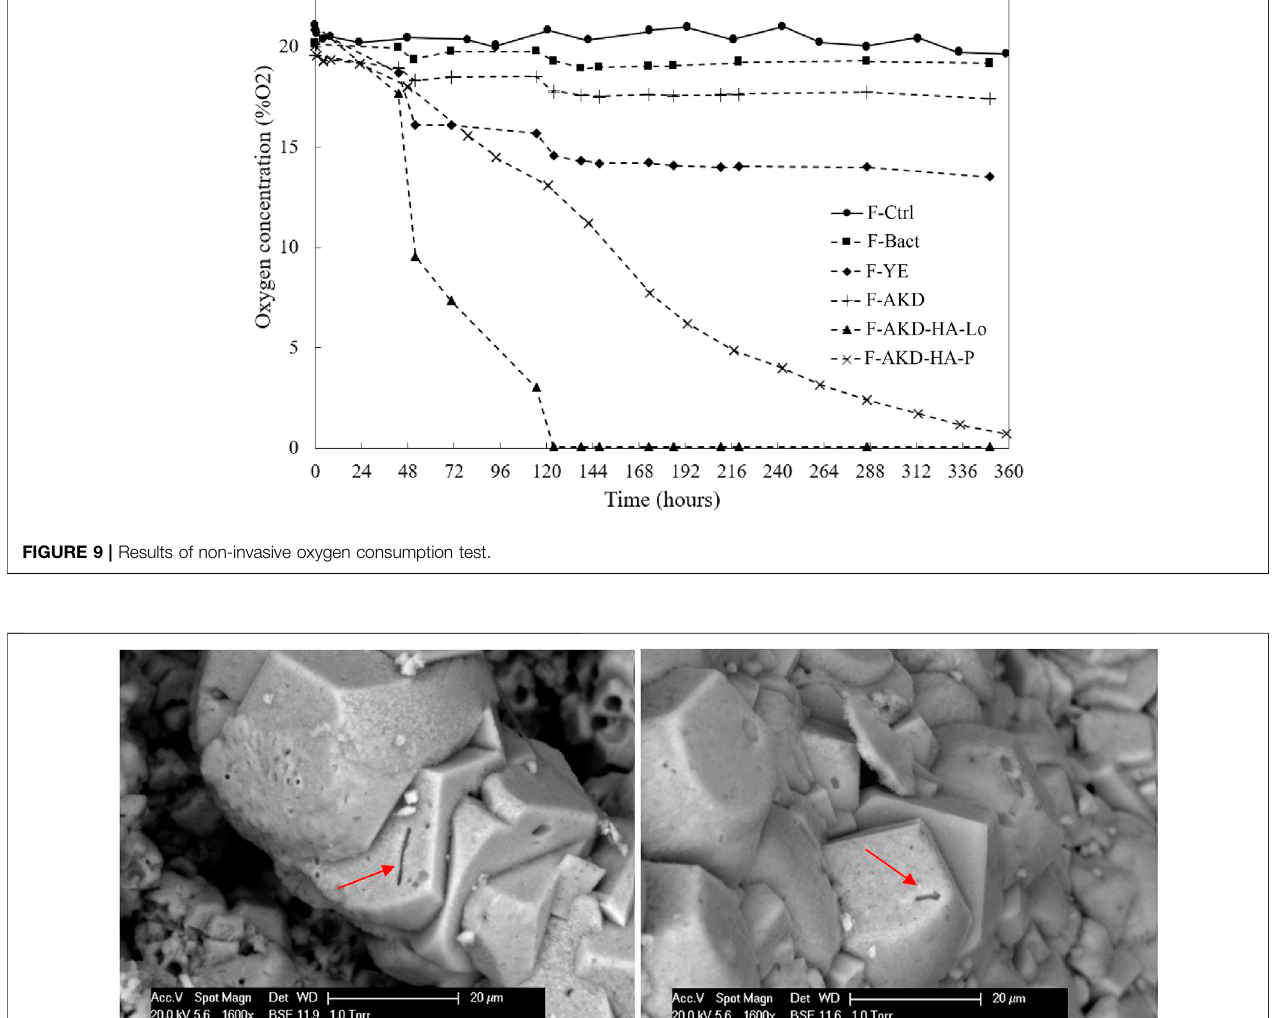
Frontiers in Built Environment |